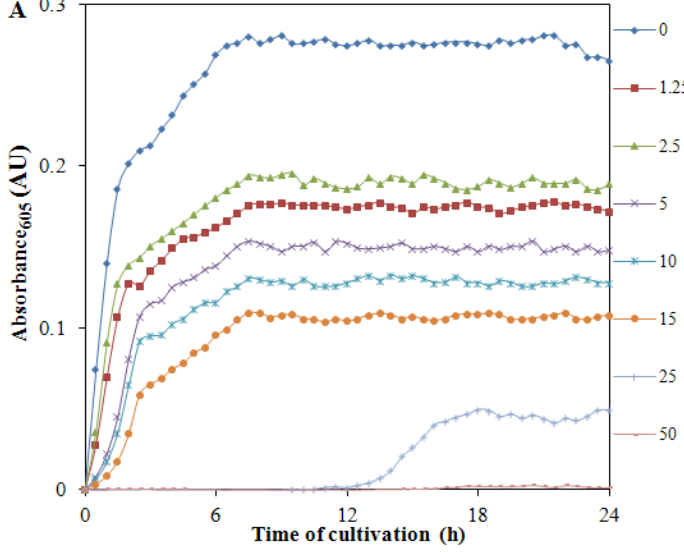
Figure 4. Spectrophotometric analysis of cadmium(II) ions treated Staphylococcus aureus . ( A ) Dependencies of growth of bacteria on the applied concentration of cadmium(II)